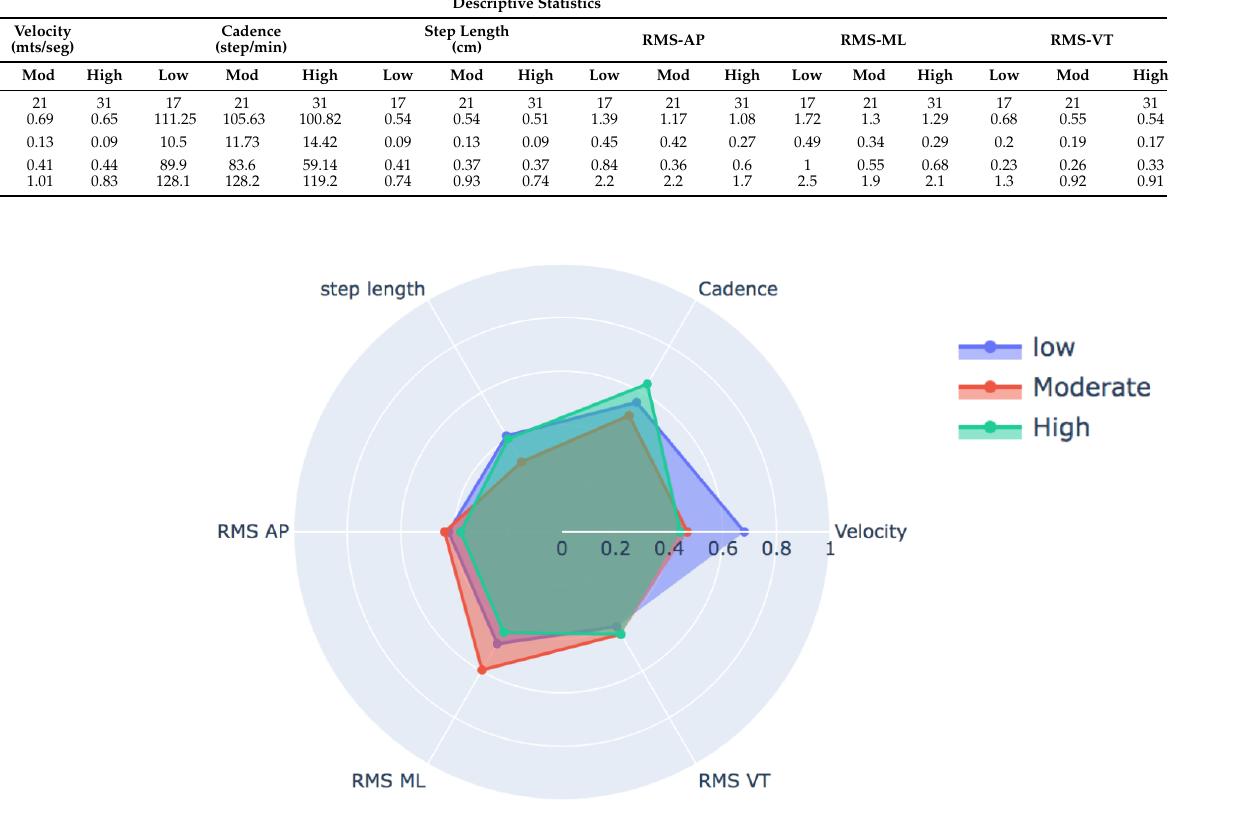
Figure 2. Gait characteristics according to degree of FOF. Variable values expressed in